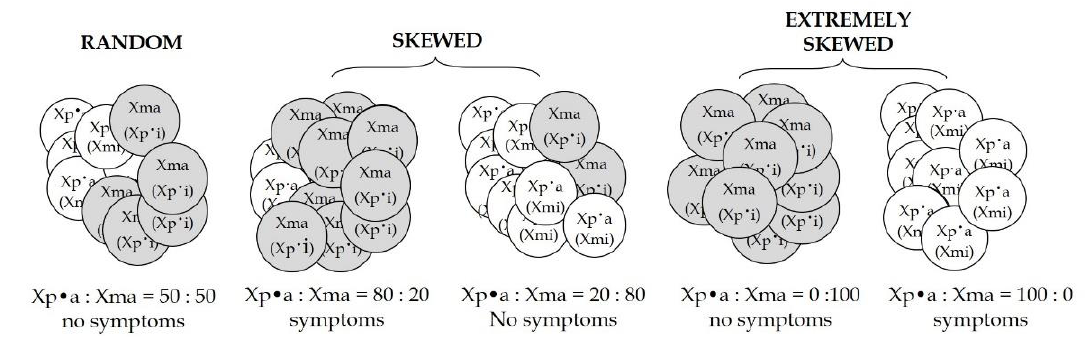
Figure 2. Example of cellular mosaicism in a female carrier of X-linked disease. The figure represents an example of (a) a random XCI pattern with the same percentage of cells expressing the paternal (white) mutated X chromosome (Xp•) and the maternal (grey) X chromosome (Xm) (on the left); (b) a skewed XCI pattern with a higher percentage of cells expressing the maternal X chromosome that determines the absence of symptoms or a skewed XCI pattern with a higher percentage of cells expressing the Xp • that determines the presence of symptoms (in the center); (c) an extremely skewed XCI with a higher percentage of cells expressing the maternal X chromosome that determines the absence of symptoms or an extremely skewed XCI pattern with a higher percentage of cells expressing the Xp • that determines the presence of symptoms (on the right). a = activated; i = inactivated.